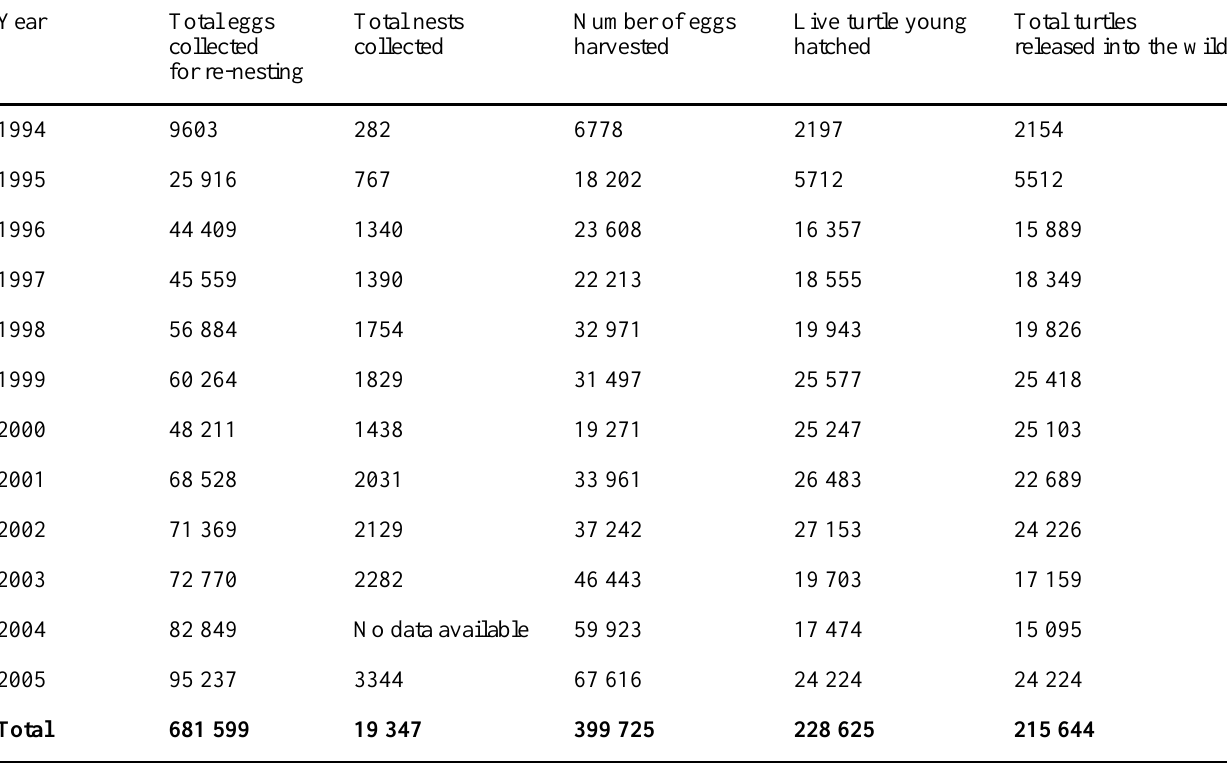
Year Total eggs